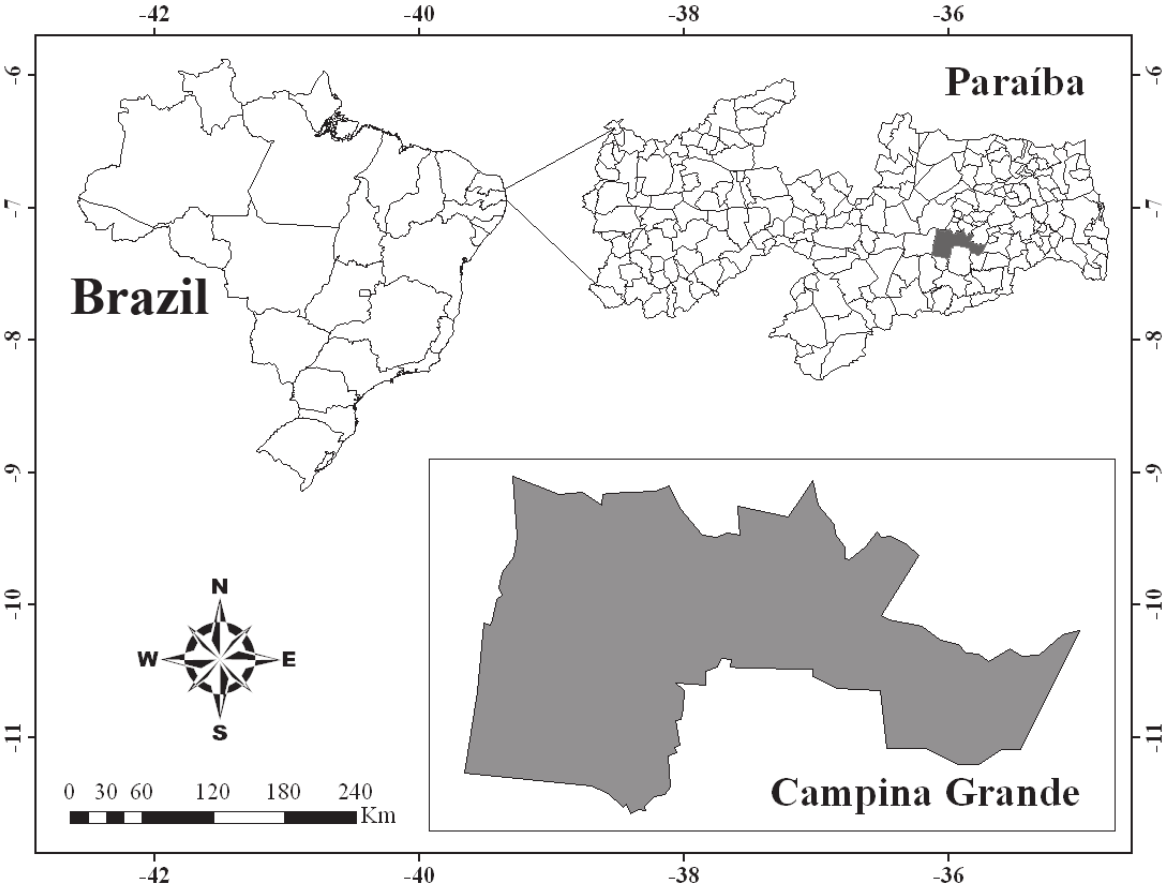
Figure 1 - Map of the study area; municipality of Campina Grande, Paraíba State,